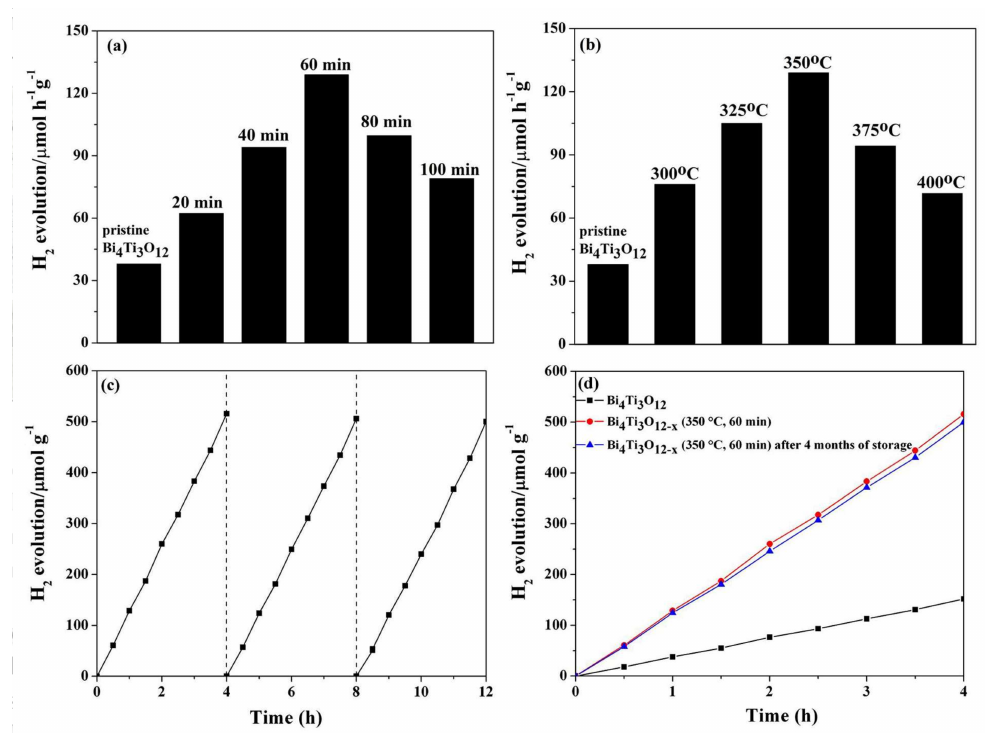
Figure 4. The hydrogen evolution rate over the pristine Bi 4 Ti 3 O 12 and the Bi 4 Ti 3 O 12 − x after chemical reduction treated ( a ) at 350 ◦ C for various times; ( b ) at various temperature for 60 min under visible-light irradiation ( λ > 400 nm); ( c ) recycling measure of hydrogen evolution with Bi 4 Ti 3 O 12 − x (350 ◦ C, 60 min) under visible-light irradiation ( λ > 400 nm); ( d ) visible-light photocatalytic hydrogen evolution by fresh Bi 4 Ti 3 O 12 − x (350 ◦ C, 60 min) and Bi 4 Ti 3 O 12 − x (350 ◦ C, 60 min) after four months of storage, compared with the pristine Bi 4 Ti 3 O 12